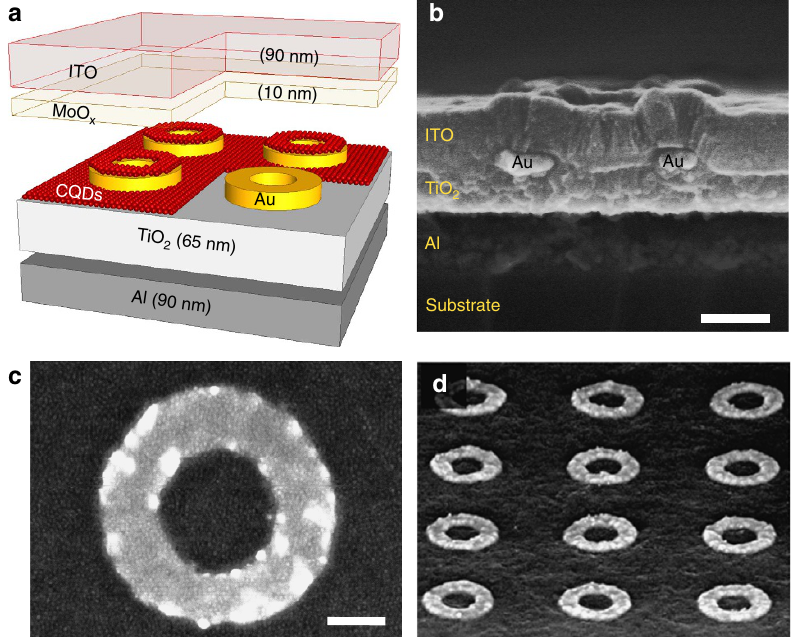
Figure 1 | A metamaterial LED. ( a ) Schematic view of the device. ( b ) SEM cross-sectional view of a real structure. The two Au regions correspond to the section of a nanoring. Scale bar, 100nm. ( c ) An SEM micrograph of a gold nanoring coated with the PbS CQDs. Scale bar, 80nm. ( d ) A tilted SEM view of the same sample (also coated with CQDs). The period is 600nm, the inner and outer radii of the rings are 73 and 157nm, respectively, and the gold thickness is